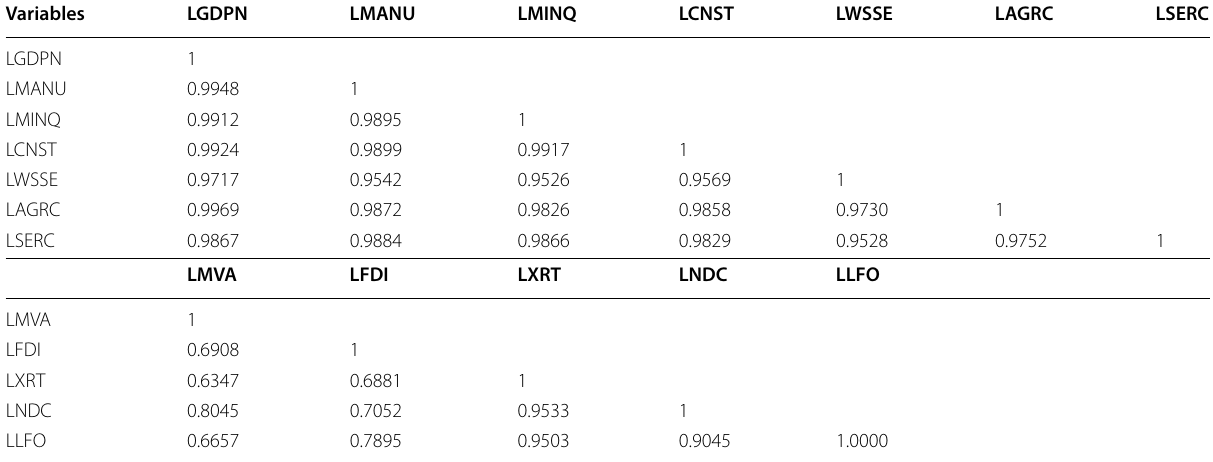
Table 2 Correlation analysis results